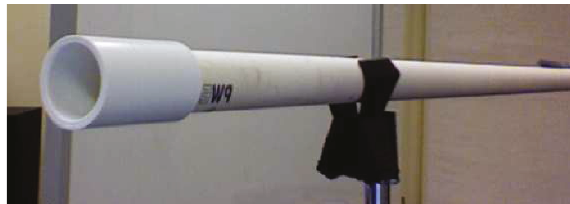
Figure 10: Instrument I3 is created to verify results that account for the junction created by appending a second tube object to the original measurement tube. It has a cylindrical open-end reflection which may, like that of instrument I2, be validated through comparison with theoretical